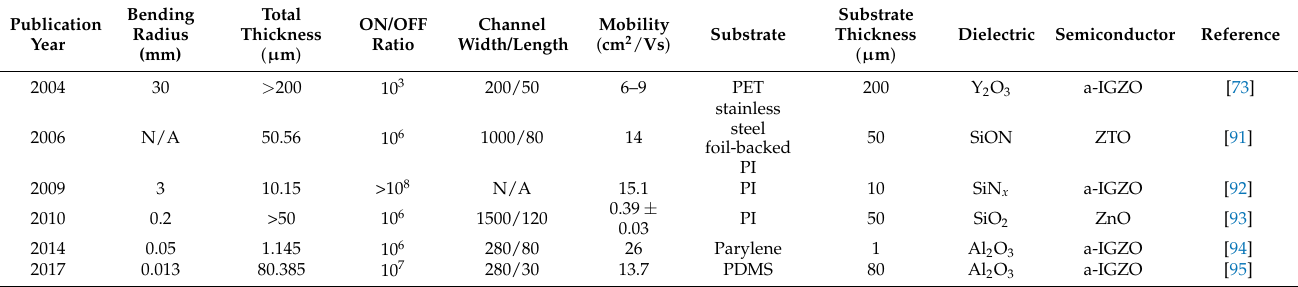
Figure 8. ( a ) Manual mechanical bending of an IGZO TFT film. The inset shows a zoomed view of the bent film ( b ) Transfer curve of the IGZO TFTs for different bending radii [96]. Reproduced with permission. Table 3. The detailed properties of the oxide TFTs in Figure